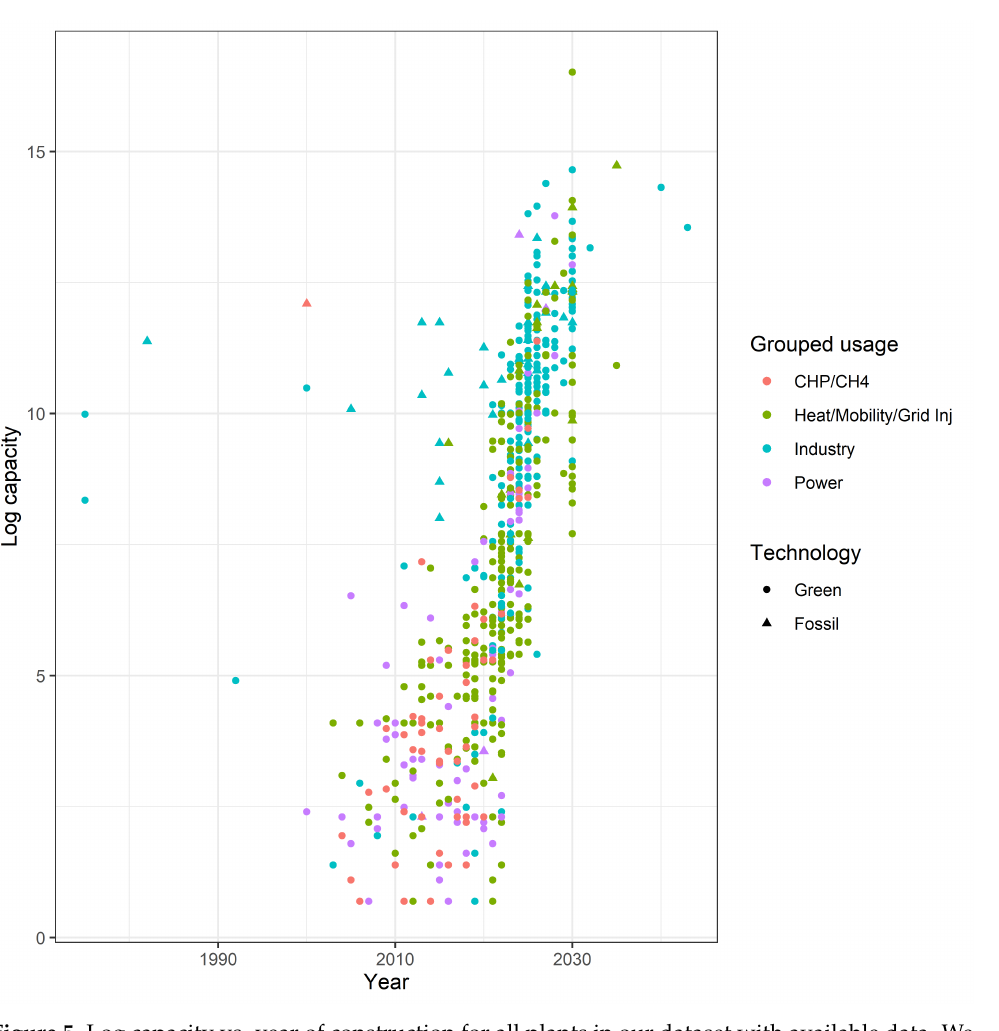
Figure 5. Log capacity vs. year of construction for all plants in our dataset with available data. We classify plants by both their technology as well as their usage, using the clusters of end-use sectors from Section 3 Figure 2. We can see the early dominance of blue plants (with a few early exceptions) by several orders of magnitude, but this is closing with